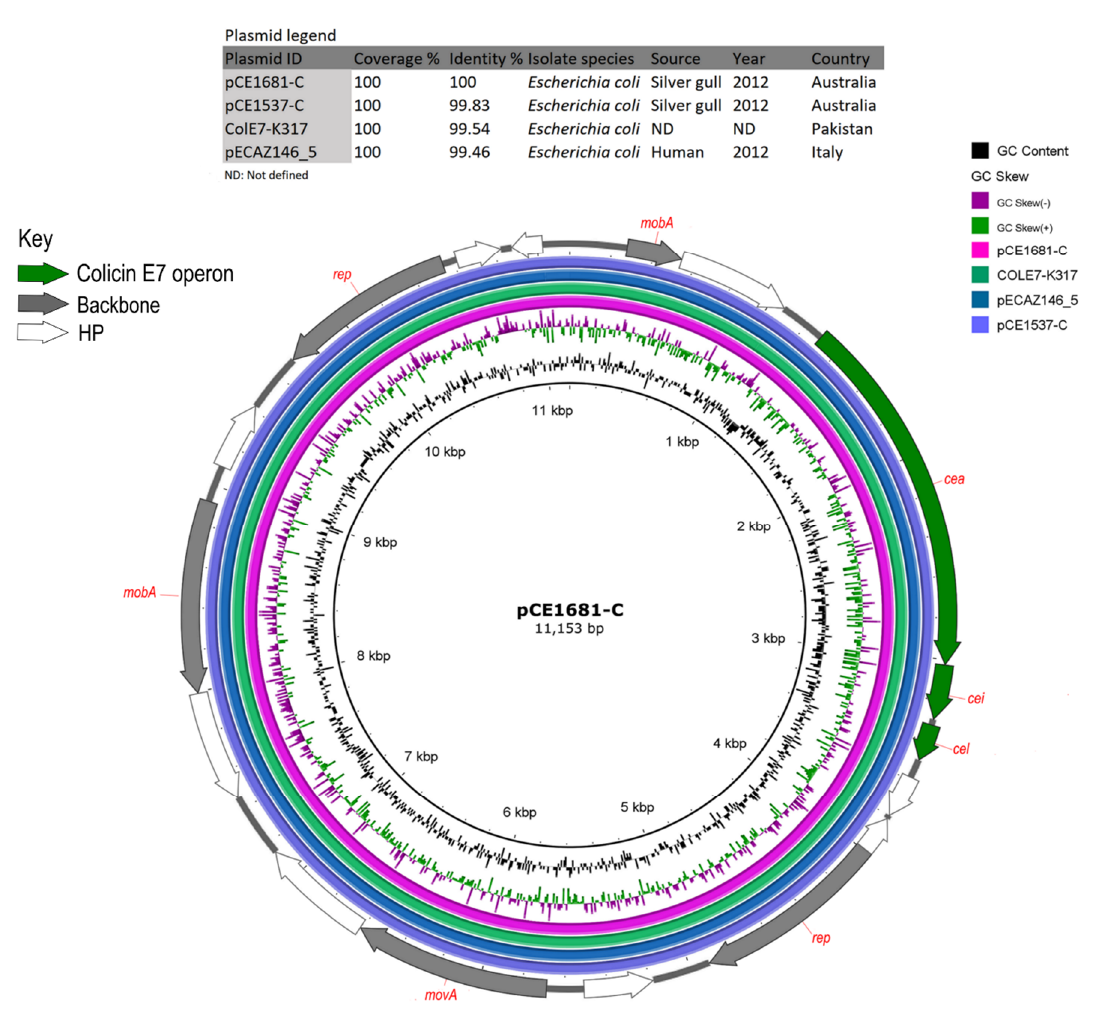
Figure 2. BRIG comparison of colicin E7 positive Col156 plasmid pCE681-C with similar plasmid sequences retrieved from GenBank. In the key, HP: hypothetical protein.